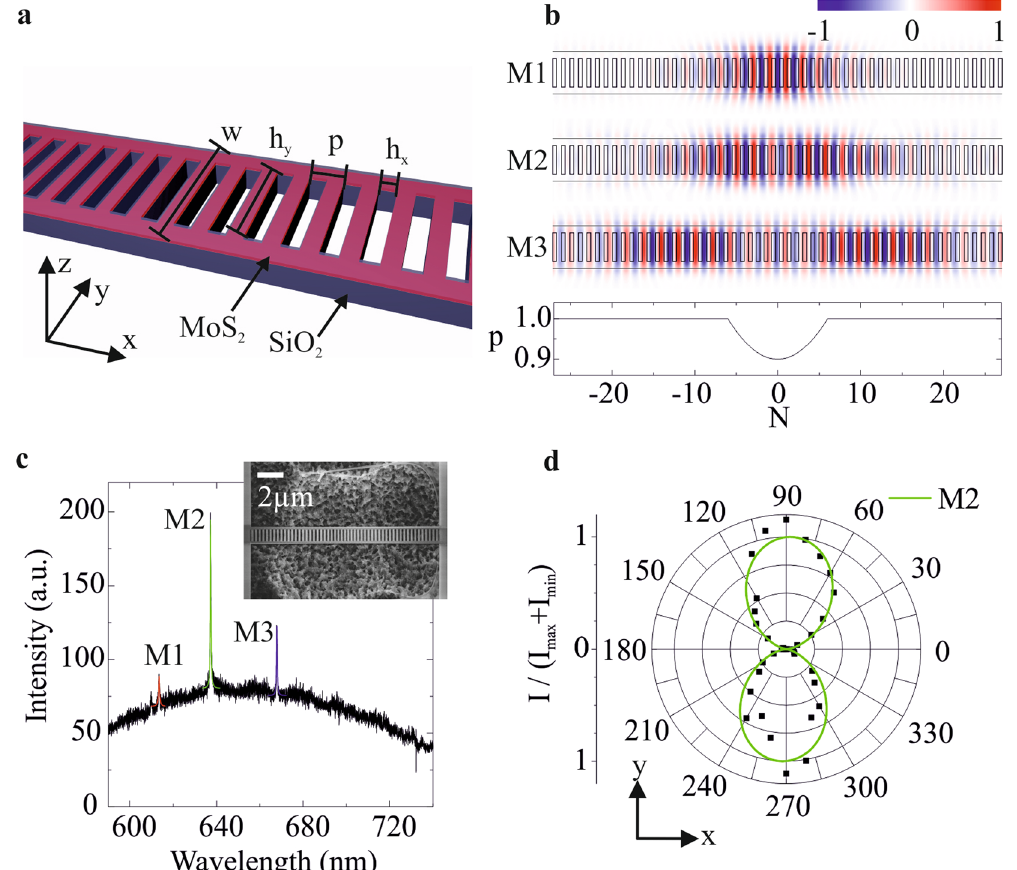
Figure 1. Structure, design and characterization. ( a ) Layout of the ladder-type SiO 2 (purple) PCC covered on top by a CVD-grown MoS 2 monolayer (pink). ( b ) Upper panels: E y field distribution in the PCC (sketched) of the modes M1, M2, and M3 obtained from FDTD simulation. Lower panel: Period variation in the photonic crystal as a function of the hole position N along the ladder (counted from the center). The defined parabolic perturbation of the period forms the cavity. ( c ) PL spectrum of a typical PCC showing the broad MoS 2 emission decorated with three modes, M1, M2 and M3, which are fitted with Lorentzians (colored solid lines). Inset: Scanning electron microscope (SEM) image of a fabricated PCC. ( d ) Normalized and background corrected peak intensities of the M2 mode (symbols) as a function of the polarization angle and fit (green line) proving